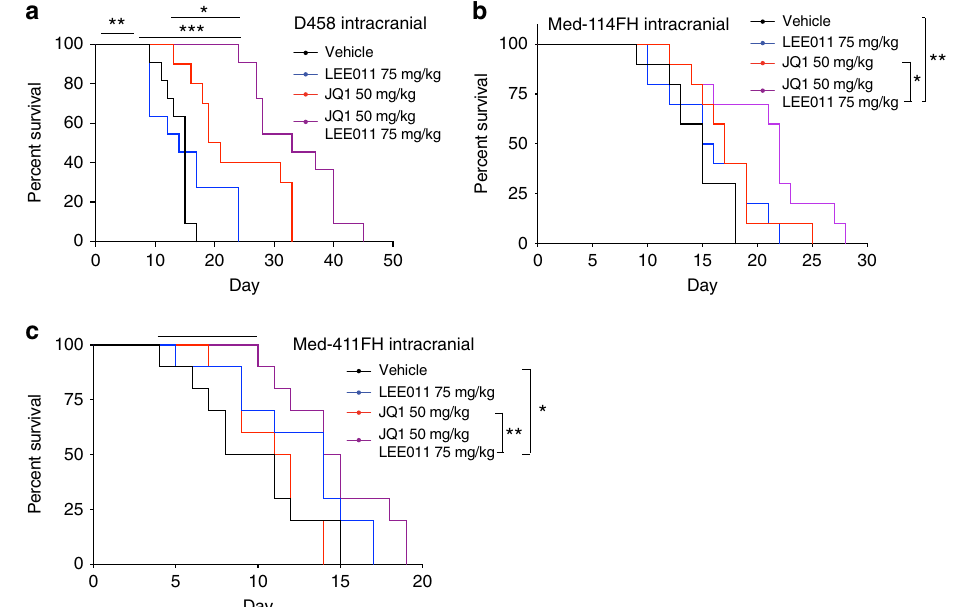
Fig. 9 CDK4/6 inhibition attenuates resistance to BETi in intracranial models a Kaplan – Meier survival curves of mice bearing intracranial D458 xenografts treated with vehicle, JQ1 (50mg/kg/day), LEE011 (75mg/kg/day) or the combination of both compounds (JQ1 50mg/kg/day and LEE011 75mg/kg/day). Asterisks denote statistically signi fi cant differences (* p <0.05, ** p <0.01, *** p <0.001) as determined by log-rank (Mantel-Cox) tests. b Kaplan – Meier survival curves of mice bearing intracranial Med114 xenografts treated with vehicle, JQ1 (50mg/kg/day), LEE011 (75mg/kg/day) or the combination of both compounds (JQ1 50mg/kg/day and LEE011 75mg/kg/day). Asterisks denote statistically signi fi cant differences (* p <0.05, ** p <0.01, *** p <0.001) as determined by log-rank (Mantel-Cox) tests. c Kaplan – Meier survival curves of mice bearing intracranial Med411 xenografts treated with vehicle, JQ1 (50mg/kg/day), LEE011 (75mg/kg/day) or the combination of both compounds (JQ1 50mg/kg/day and LEE011 75mg/kg/day). Asterisks denote statistically signi fi cant differences (* p <0.05, ** p <0.01, *** p <0.001) as determined by log-rank (Mantel-Cox)